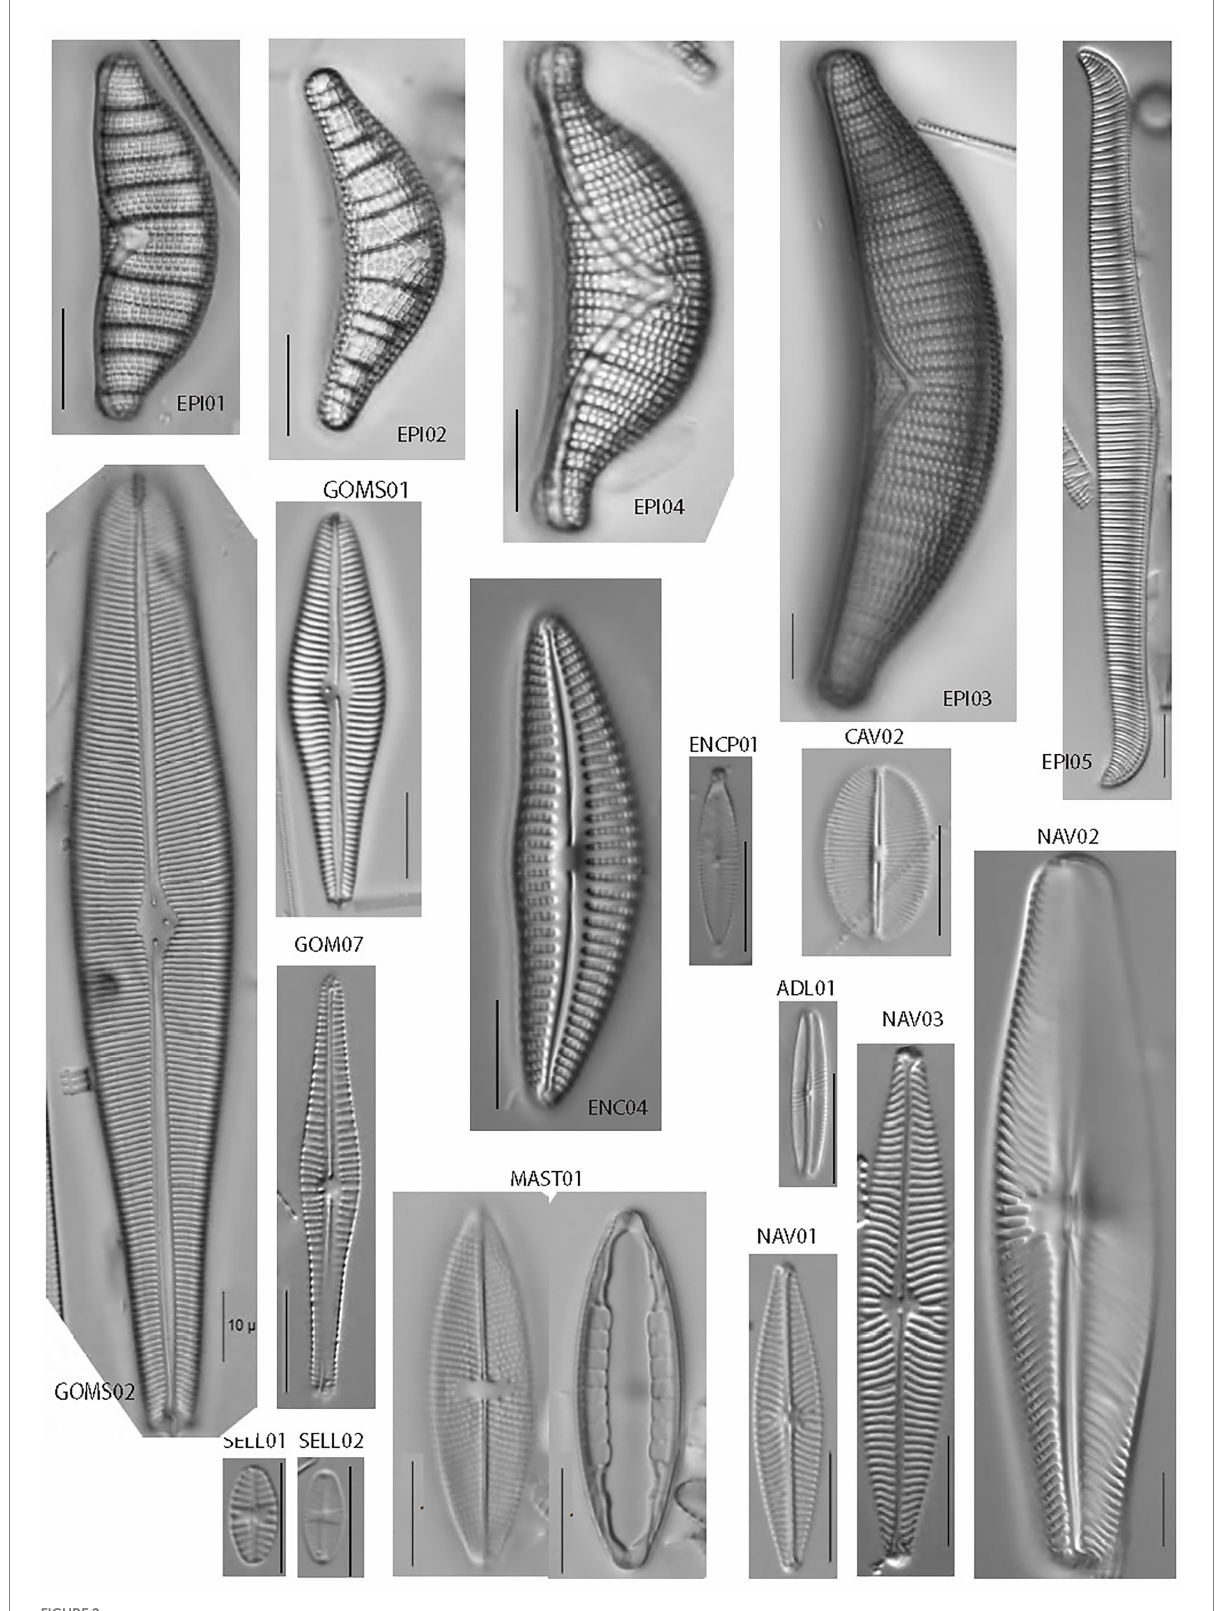
FIGURE 2 Light micrographs of common epithemioid and biraphid diatoms identified in this study. All scale bars are 10 microns in